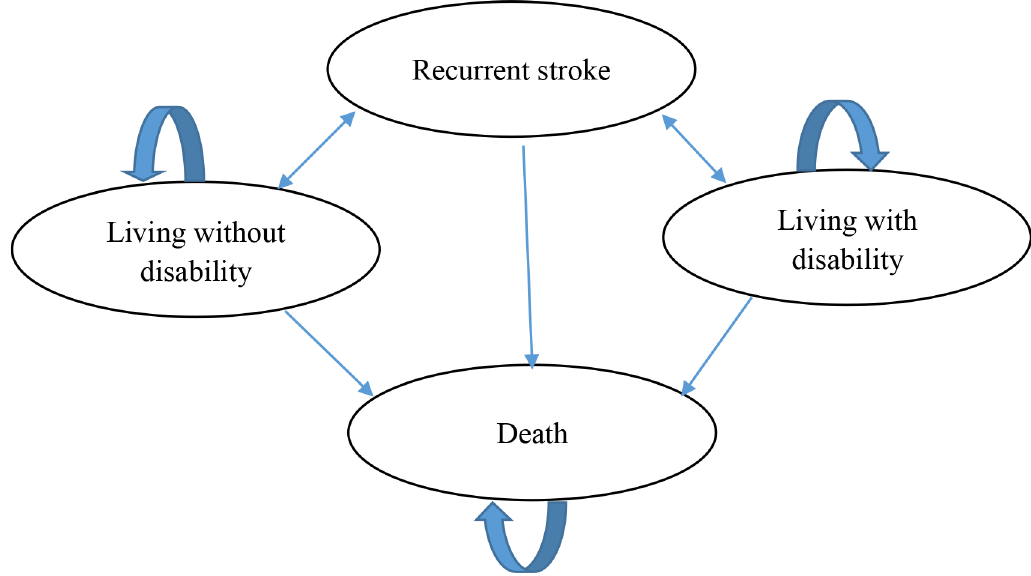
Fig 1. Simplified schematic of the recurrent stroke Markov micro-simulation